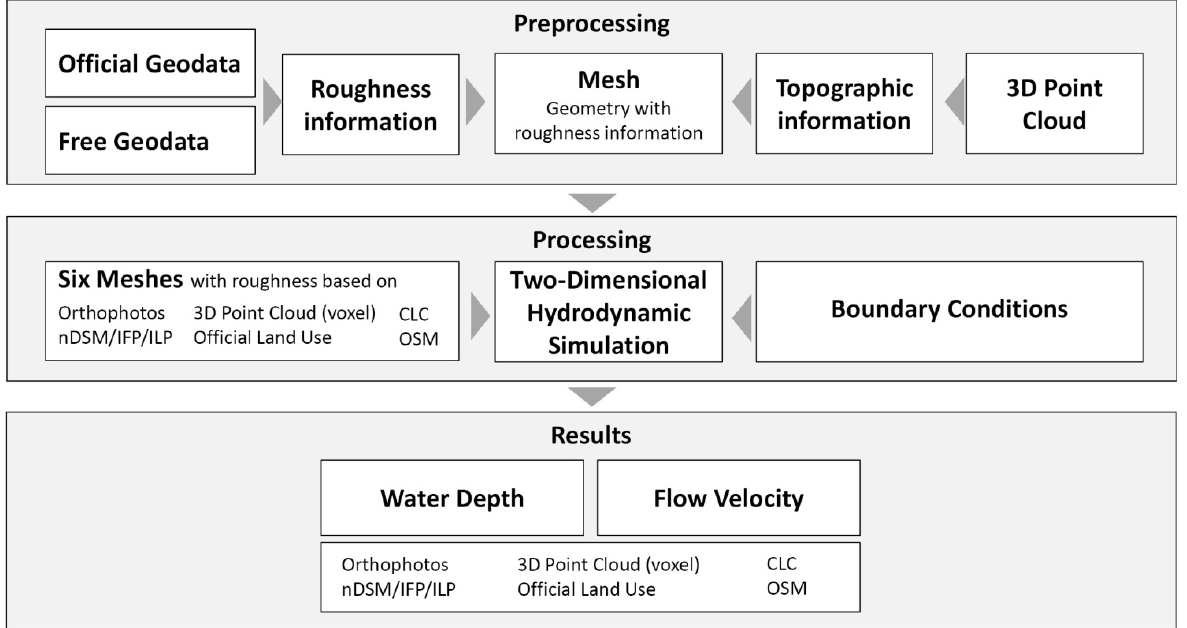
Figure 2. Workflow of GIS-based roughness derivation and comparison for flood